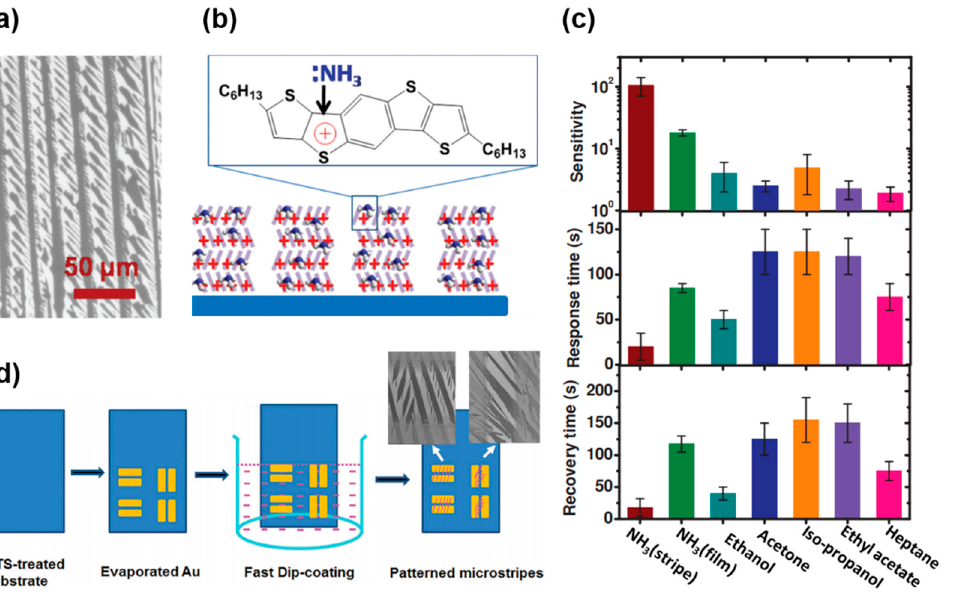
Figure 5. ( a ) Scanning electron microscopy image of C6-BTBDT microstripes, ( b ) sensing mechanism of C6-BTBDT with NH 3 , ( c ) sensitivity, response time, and recovery time of C6-BTBDT FET sensors according to the target gas molecules [81]. Sensitivity is defined as I NH3-off / I NH3-on . Copyright 2013 Wiley. ( d ) Fabrication procedure and scanning electron microscopy images of C6-BTBDT microstripes on Au source/drain electrodes [82]. Copyright 2016 Royal Society of Chemistry.